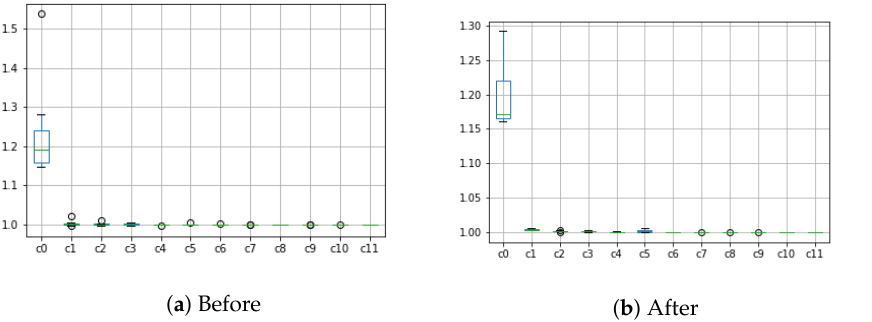
Figure 6. Outlier elimination using the heat equation adjustment